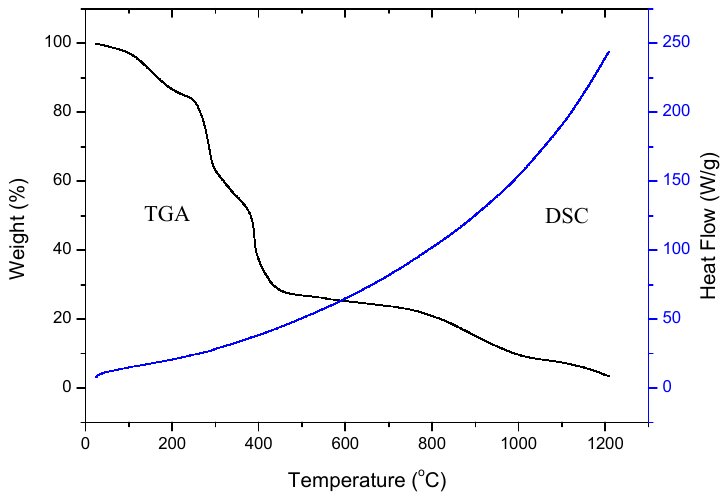
Figure 6. TGA curve and DSC plot of Ni-NP PVA gel.